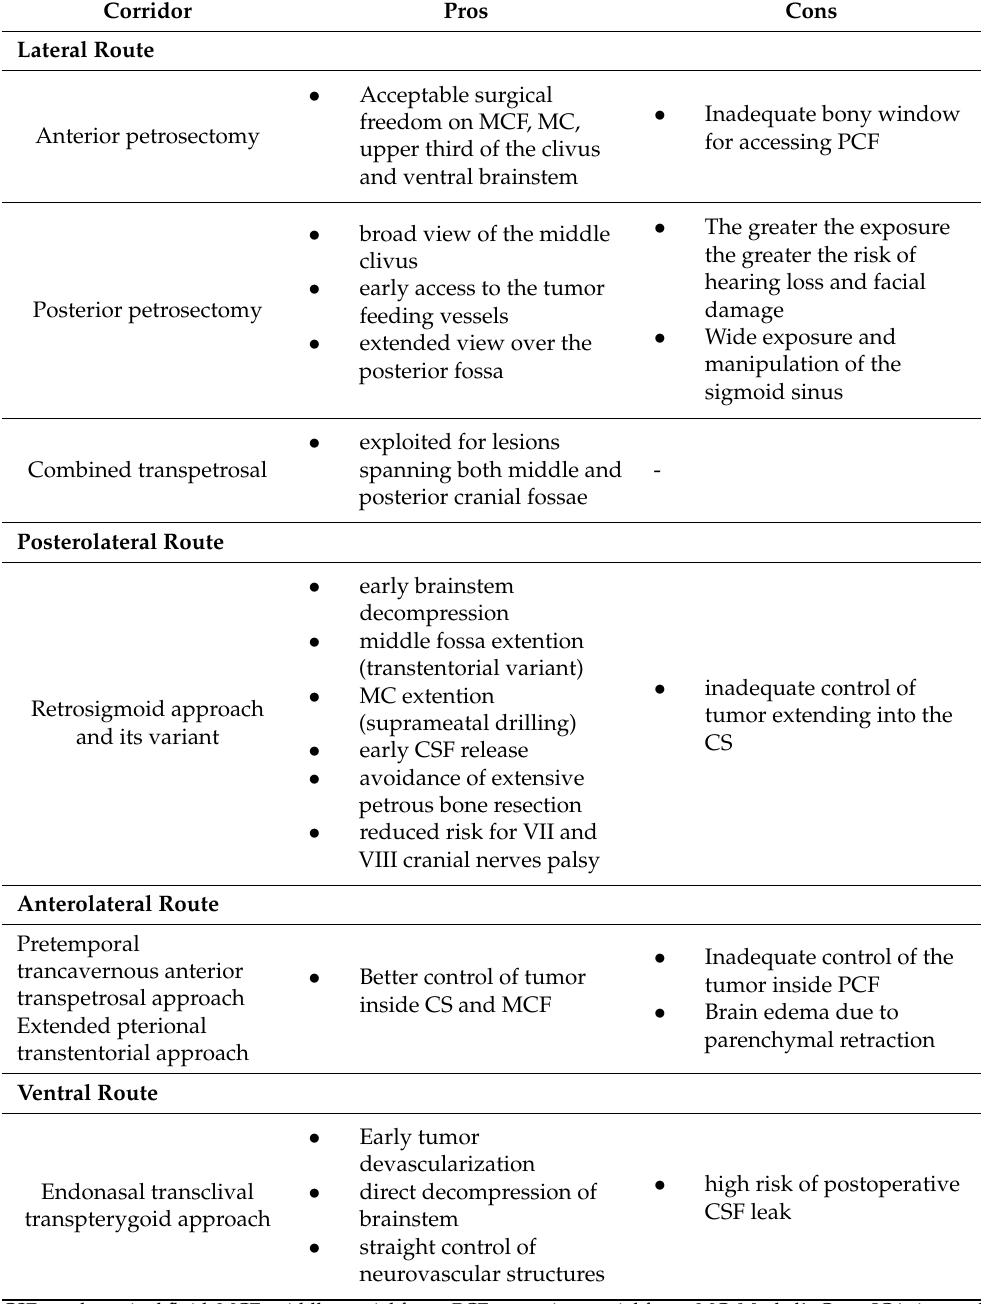
Table 4. Pros and cons for each corridor for the management of petroclival meningiomas